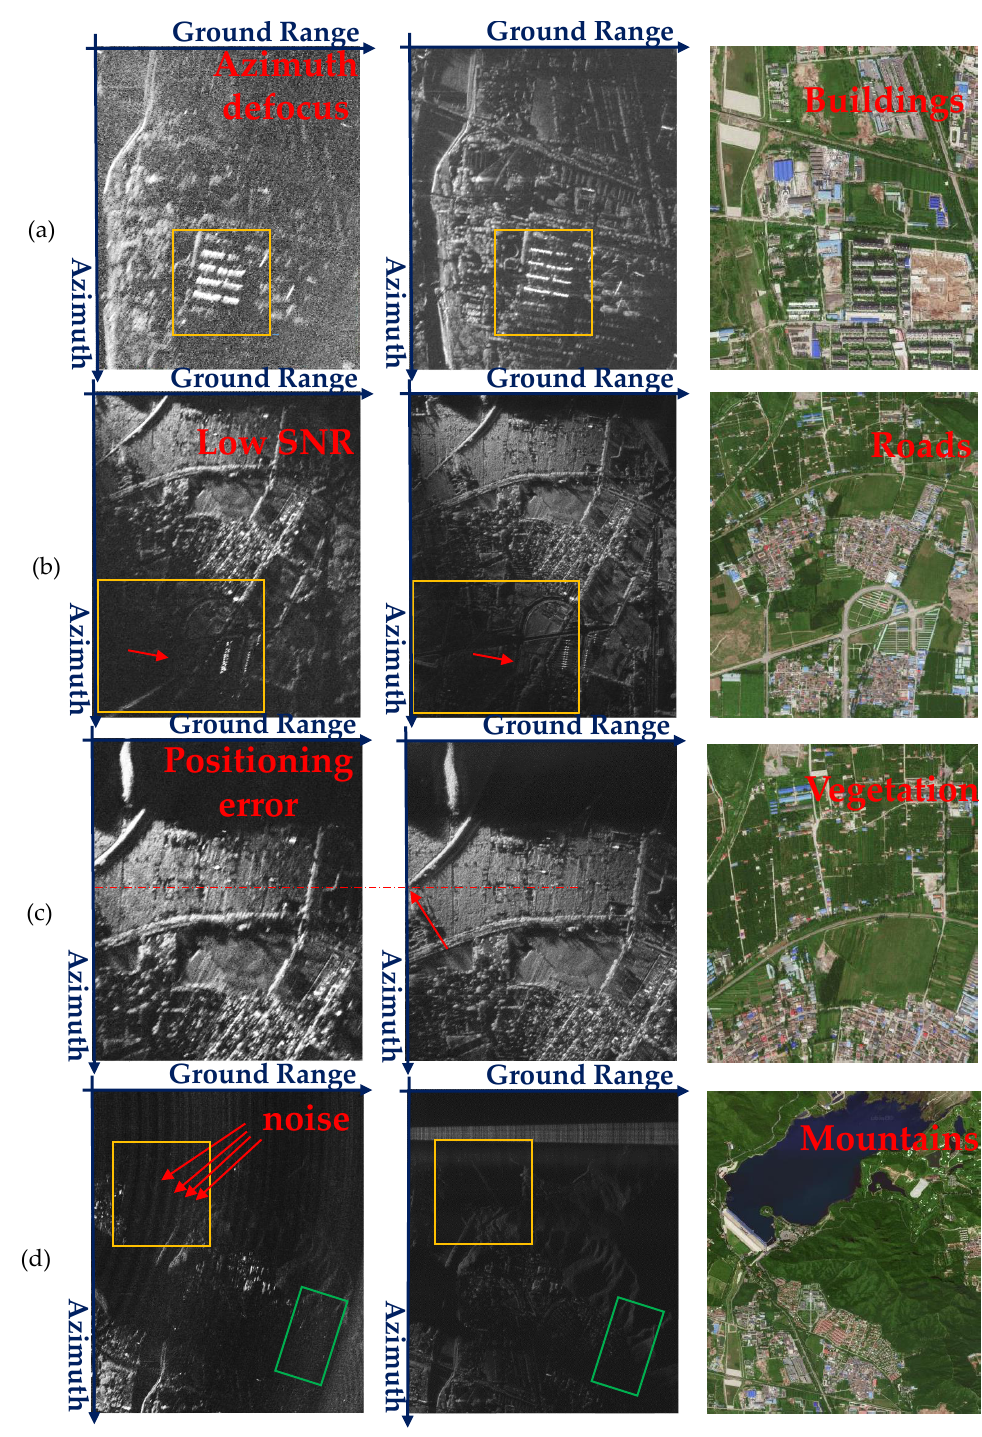
Figure 10. Comparison of the uncompensated images ( left ), the compensated images ( middle ) and the optical images ( right ) with details of the illuminated areas (A–D). ( a ) The zoomed image of A: buildings; ( b ) the zoomed image of B: roads; ( c ) the zoomed image of C: vegetation; ( d ) the zoomed image of D: